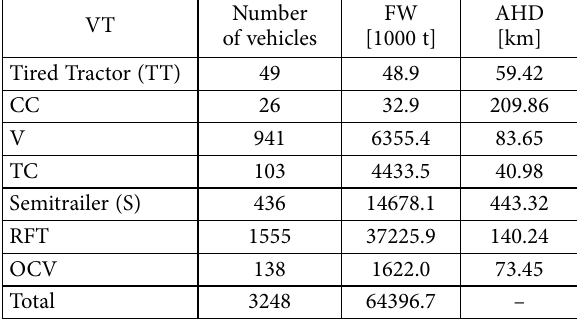
Figure 1. Sample trucks of each city in Anhui Province of China Table 1. Summary of the survey